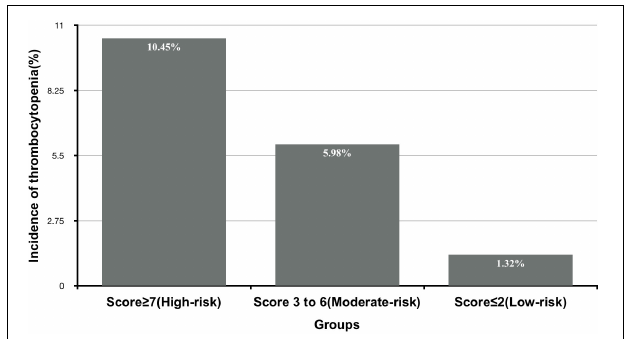
FIGURE 2 | The incidence of thrombocytopenia according to different levels of risk score derived from development data